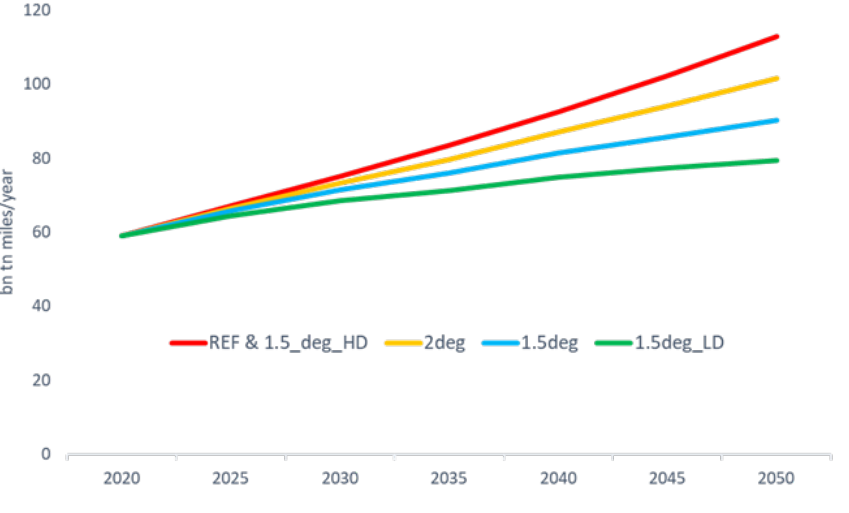
Figure 8. International shipping activity in the series of scenarios.